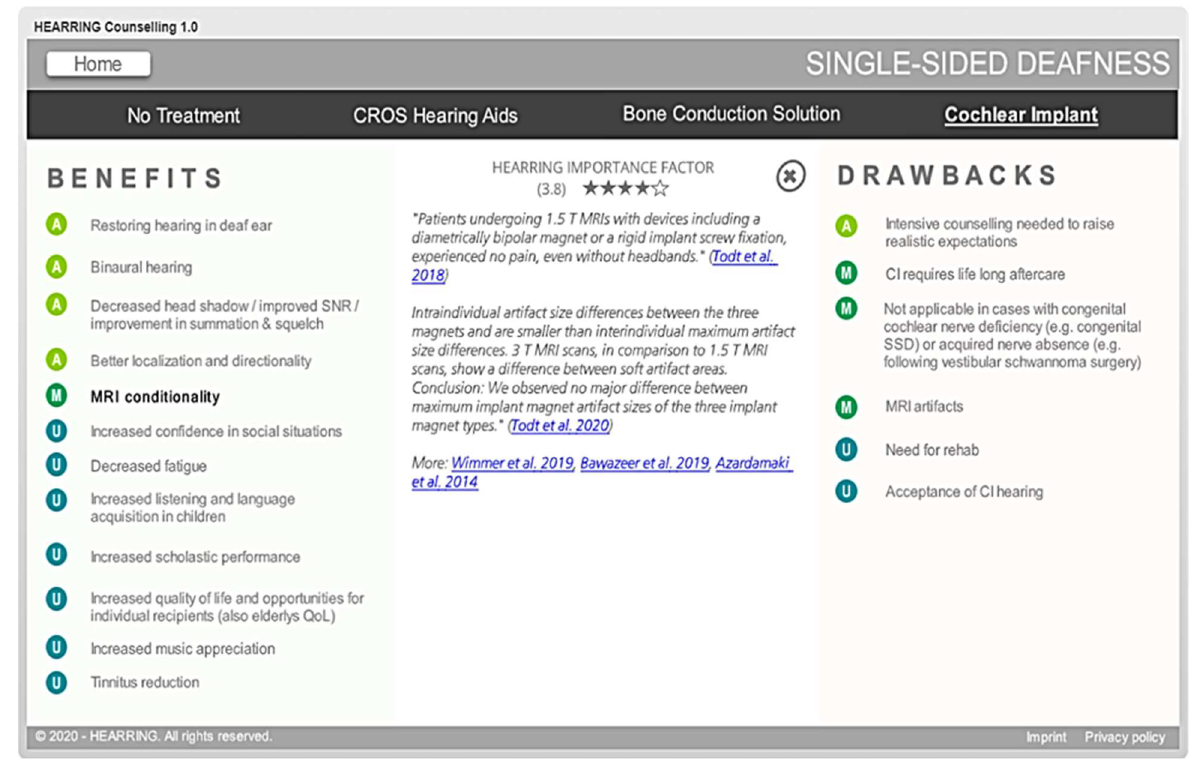
Figure 3. Inside one of the treatment options, here for single-sided deafness. In this screenshot, cochlear implants and the benefit “MRI conditionality” is